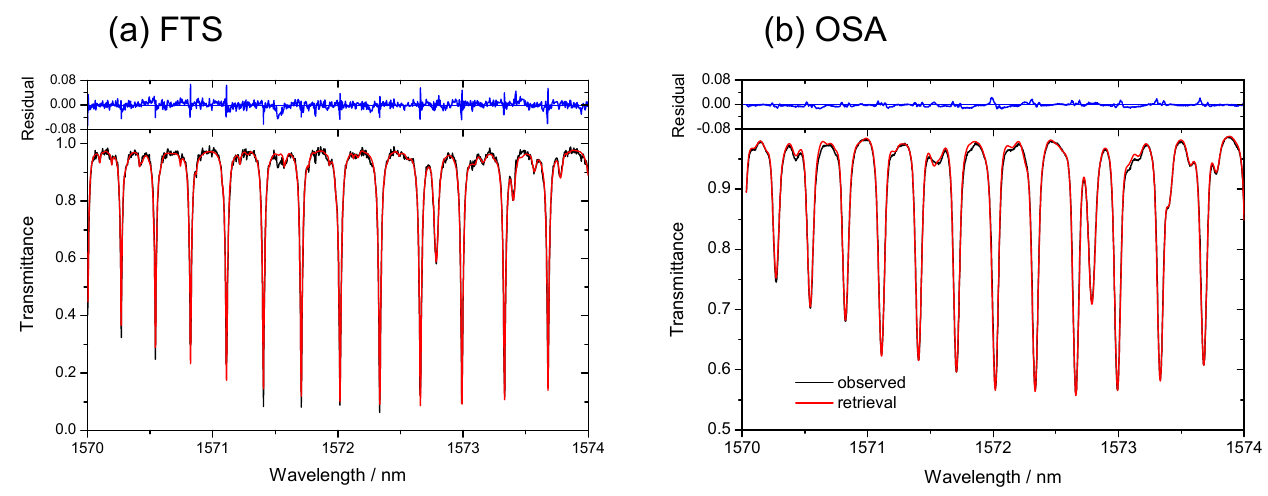
Fig. 5. Enlarged spectra shown in Fig. 2 for the OSA and the FTS after retrievals given in the Appendix section. Black curves denote the observed spectra and red ones calculated. Table 1. Column densities and column average concentrations of CO 2 at the Moshiri observatory measured by different instruments. Method Column Density Concentration a Time of Number of (10 21 molecules/cm 2 ) (ppm) Measurement b Measurements OSA c 7.890 ± 0.028 377.09 ± 1.35 9:40 ∼ 16:11 FTS d 7.800 ± 0.081 376.60 ± 3.93 10:19 ∼ 15:50 Balloon 7.934 ±